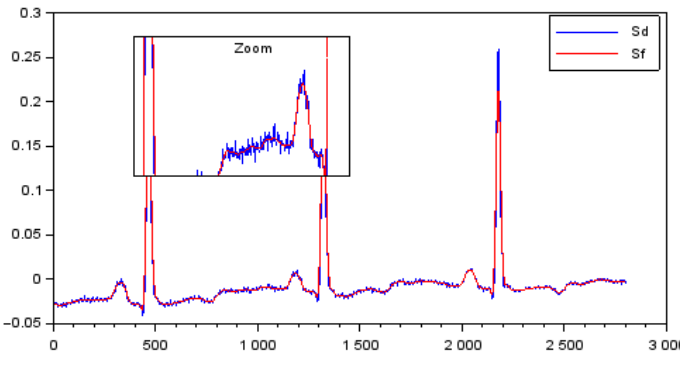
Figure 5. Detrended signal (Sd) and filtered signal (Sf).